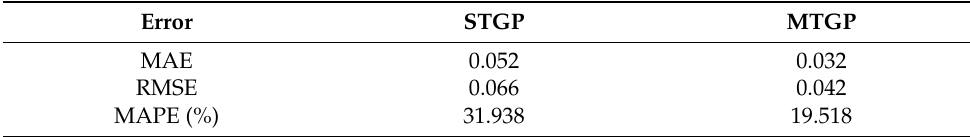
Figure 13. Prediction results of MT-LSTM, ST-MTGP, and LSTM for the extreme situation (after normalization). Table 8. Error results of STGP and MTGP (after normalization). Error